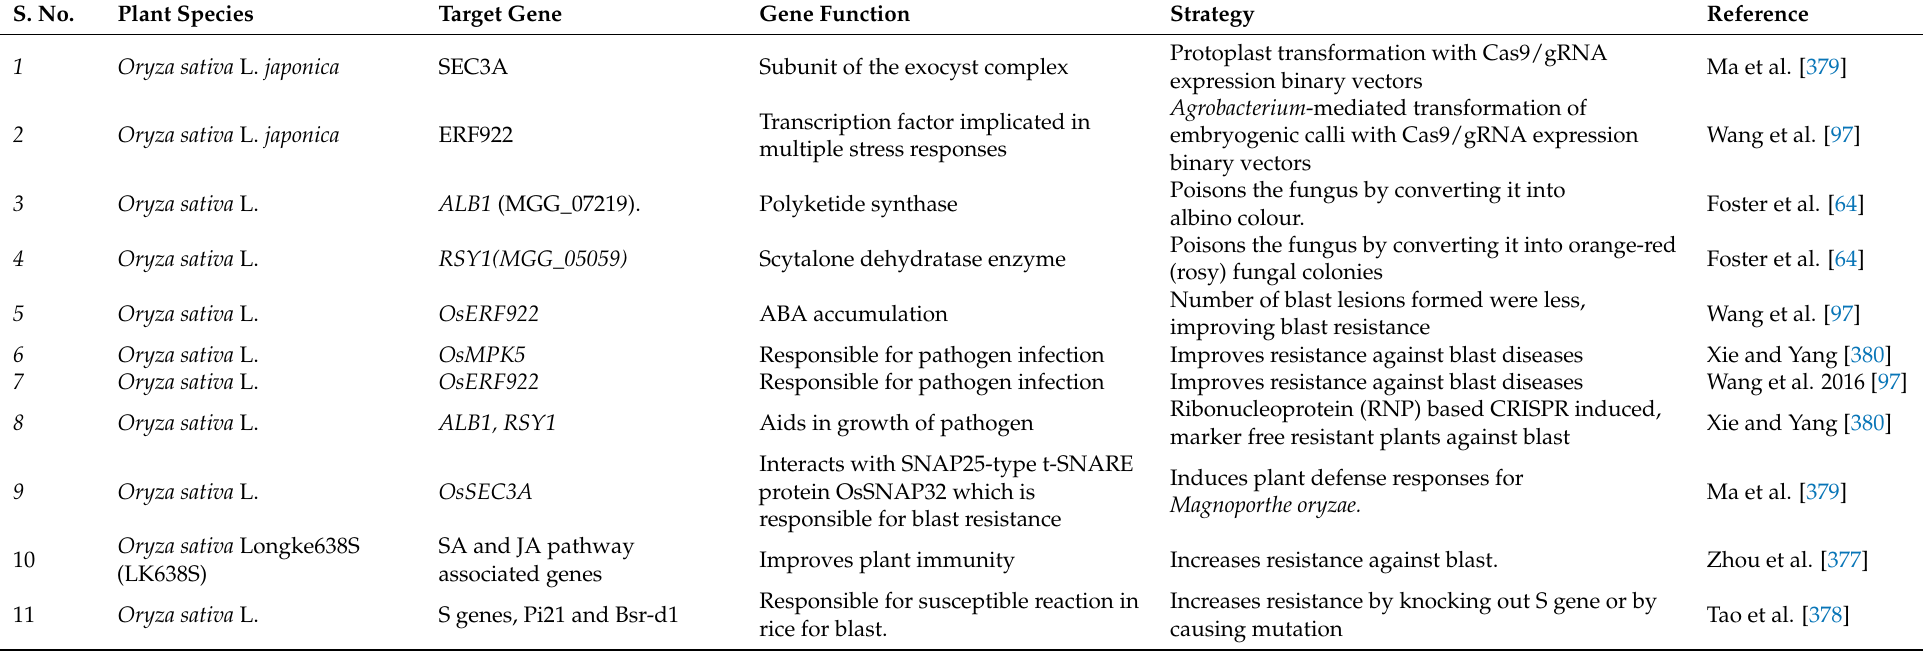
Table 6. Potential use of CRISPR Cas9 for resistance against Magnaporthe oryzae